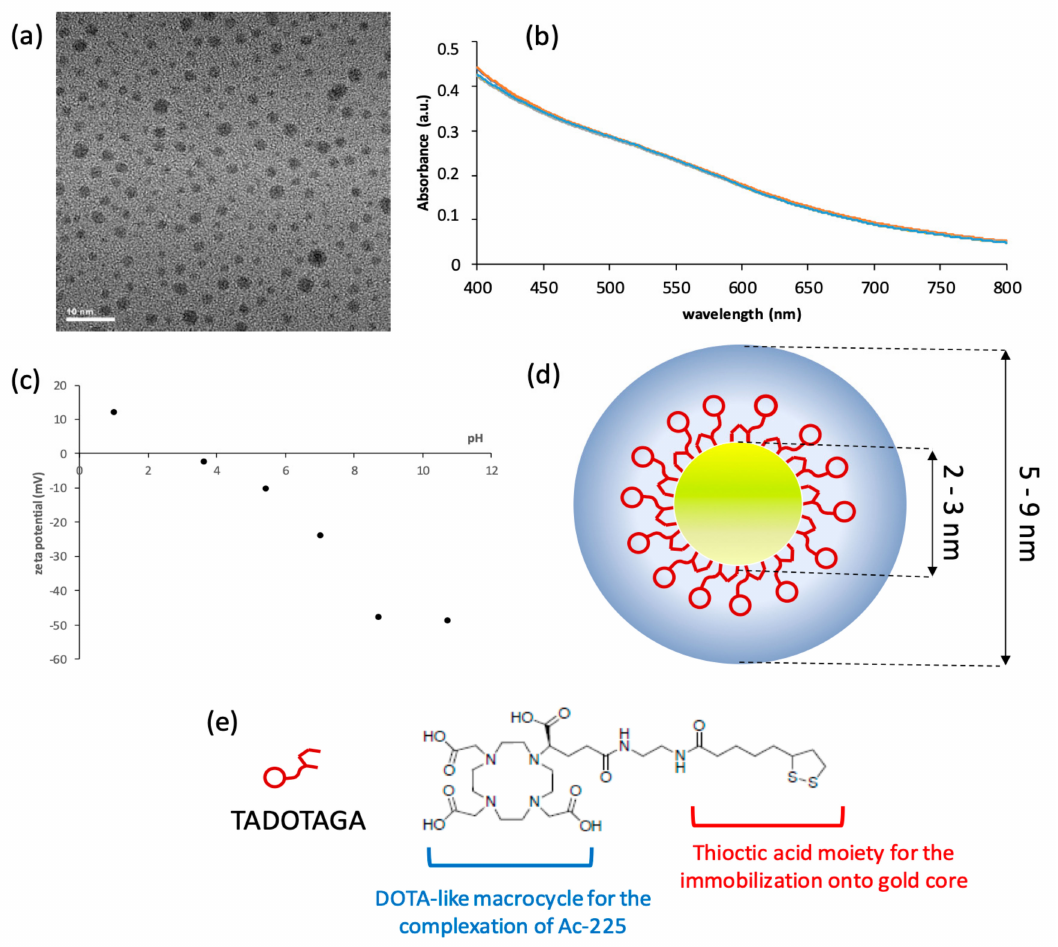
Figure 1. ( a ) TEM micrograph of Au@TADOTAGA nanoparticles; ( b ) UV-visible spectra recorded at pH 3 (blue curve), 5 (red curve), 7 (green curve), 9 (purple curve) and 11 (cyan curve); ( c ) zeta potential of an aqueous suspension of Au@TADOTAGA nanoparticles as a function of pH; ( d ) schematic representation of an Au@TADOTAGA nanoparticle (yellow: gold core; red: TADOTAGA molecules in the organic shell; blue: the immobile solvatation layer); ( e ) chemical structure of